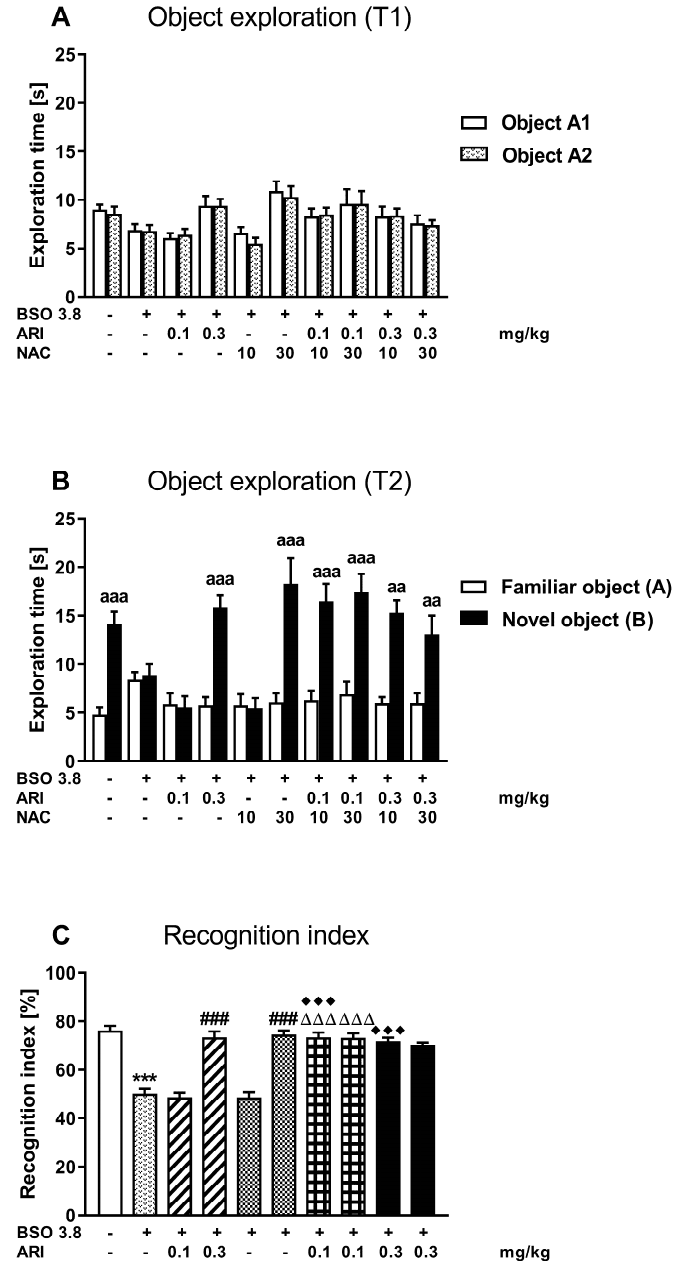
Figure 2. Effects of chronic treatment with aripiprazole (ARI) and N-acetylcysteine (NAC), alone or in combination, on cognitive functions assessed in adult 90-day-old Sprague–Dawley rats that received chronic BSO during early postnatal life (P5–P16). The impact of the studied drugs on: ( A ) exploration of two identical objects in the acquisition trials (session T1), ( B ) exploration of a novel and familiar object in the retention trial (Session T2), ( C ) on the recognition index. Data are presented as the mean ± SEM, n = 8 for each group. Letters indicate statistically significant differences between the exploration time of a novel and familiar object in the session T2 within each studied group, according to the Student’s t -test for independent samples, aaa p < 0.001, aa p < 0.01 vs. familiar object. Statistical analysis of the recognition index was performed using a one-way ANOVA for the planned comparisons; symbols indicate significance of differences between the tested groups, *** p < 0.001 vs. control, vehicle-treated group; ### p < 0.001 vs. BSO-treated group; ΔΔΔ p < 0.001 vs. BSO + ARI (0.1 mg/kg)-treated group; ♦♦♦ p < 0.001 vs. BSO + NAC (10 mg/kg)-treated group.